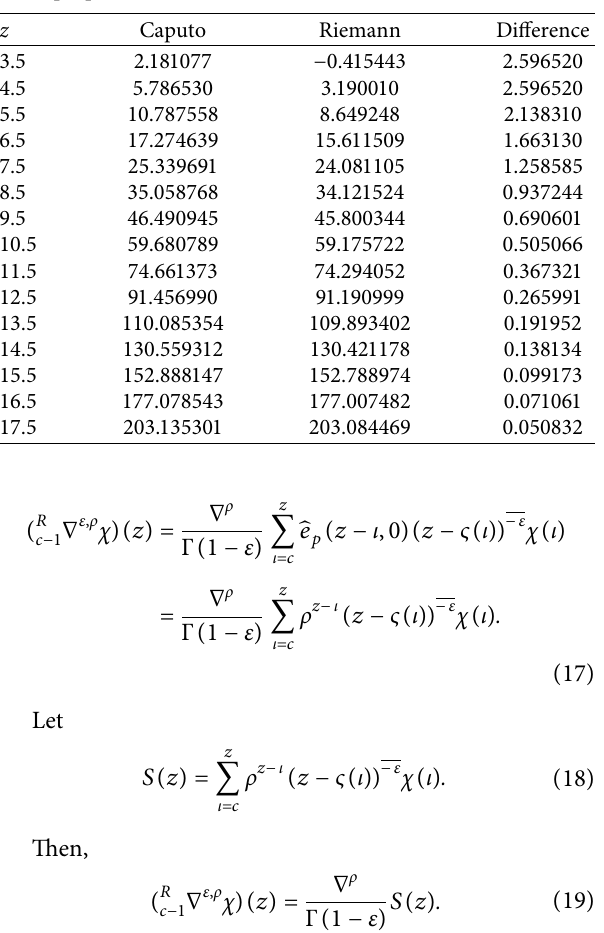
Figure 1: The relation between nabla Riemann and Caputo fractional proportional differences. Table 1: The relation between nabla Riemann and Caputo frac- tional proportional